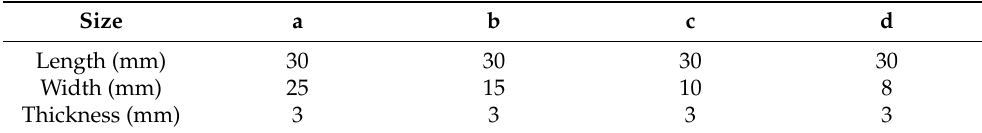
Table 2. Variation of the silica gel width.